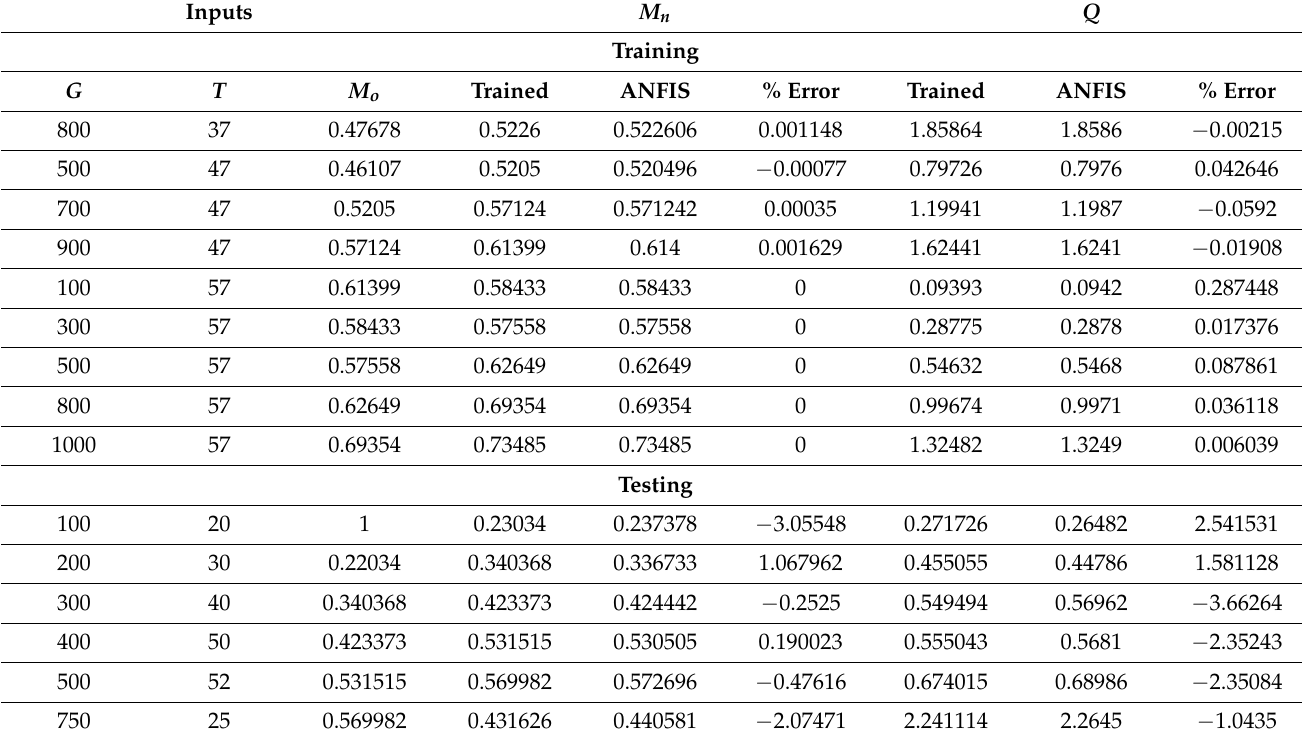
Table 1 depicts a comparison between the different calculated data and estimated data by the ANFIS controller for PV AC-WPS for both the training and testing data. It illustrates a very good agreement between data obtained by the prescribed methods as in Figure 12a,b for the modulation index and flow rate respectively with RMSE of 5.3255 × 10 − 6 . The percentage error is also shown in Table 1 for the trained and ANFIS-perceived modulation index and water flow rate. The effectiveness of the training process and the deployment of such an adaptive controller was demonstrated by the fact that the modulation index error and water flow rate error were almost both zero or very close to zero. For the testing data, the percentage error is less than 3% for the modulation index and flow rate.